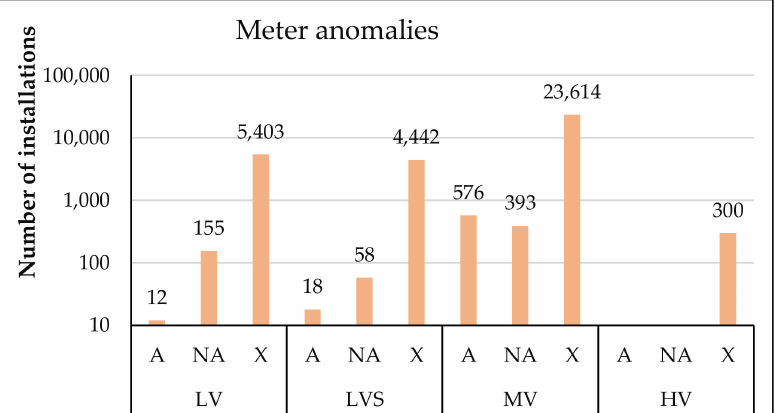
Figure 3. Meter anomalies (A—Abnormal; NA—Not-abnormal; X—Not